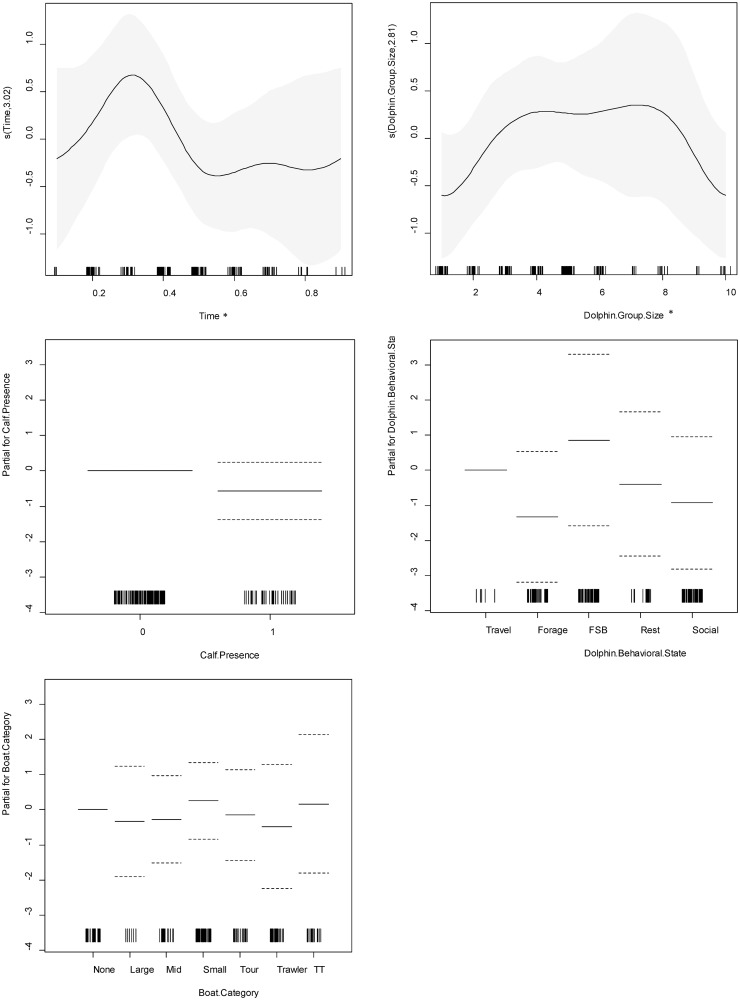
Charts for the partial contribution of individual explanatory variables in the fitted GAM for linearity.Includes A) time of day, B) dolphin group size, C) calf presence, D) dolphin behavioral state, and E) vessel category. The rugplot along the x-axis indicates the number of observations for each factor. The gray shading for smooth terms, and the dotted lines for linear terms, indicate the 95% confidence intervals. On the y-axis, values >0 indicate a positive correlation with linearity, values <0 indicate a negative correlation, and a value of 0 indicates no effect. An asterisk (*) indicates a variable with a statistically significant effect at alpha level 0.05. A closed circle (•) indicates a variable with a statistically significant effect at alpha level 0.1.